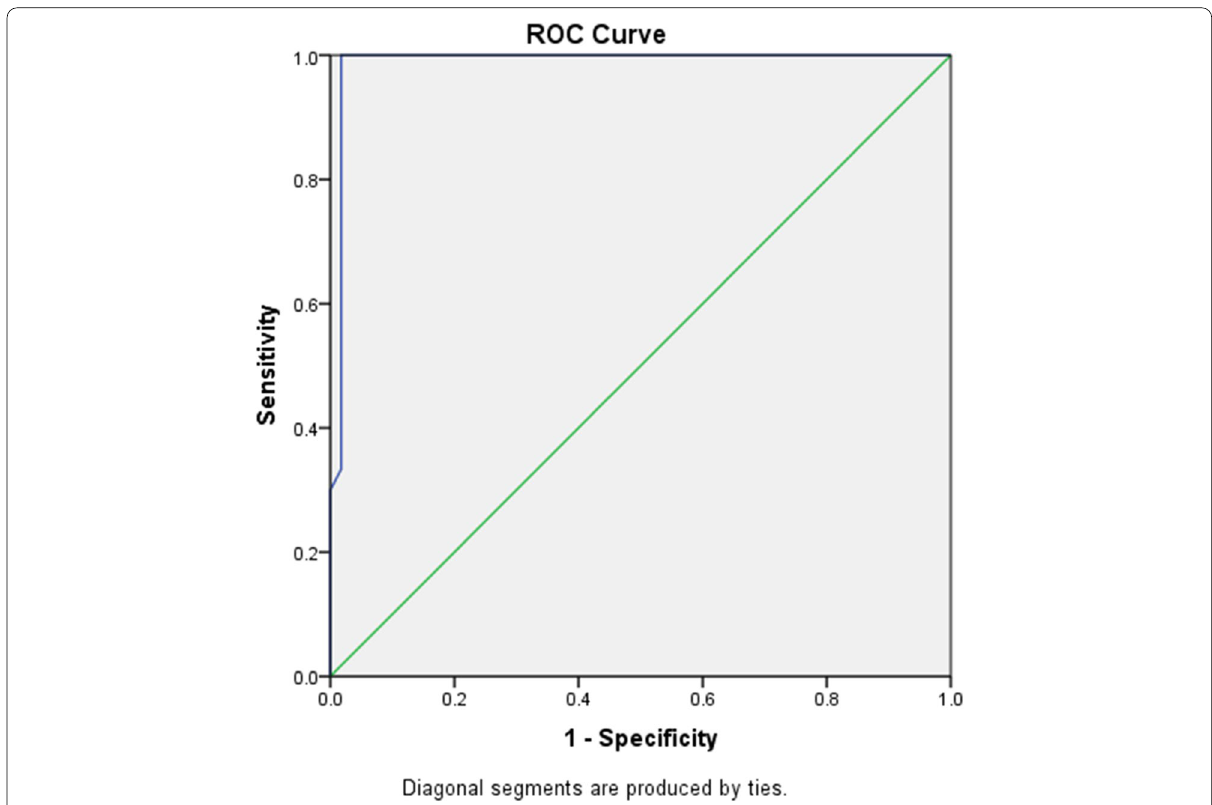
Fig. 2 ROC curve analyses identified nesfatin‑1 levels of 5.5 ng/dl as cut‑off value for diagnosis of DMT2 with 0.97 for area under curve (AUC), ≤ 100% sensitivity, 96.7% specificity, 96.8% positive predictive value (PPV), 100% negative predictive value (NPV), and 98.3%